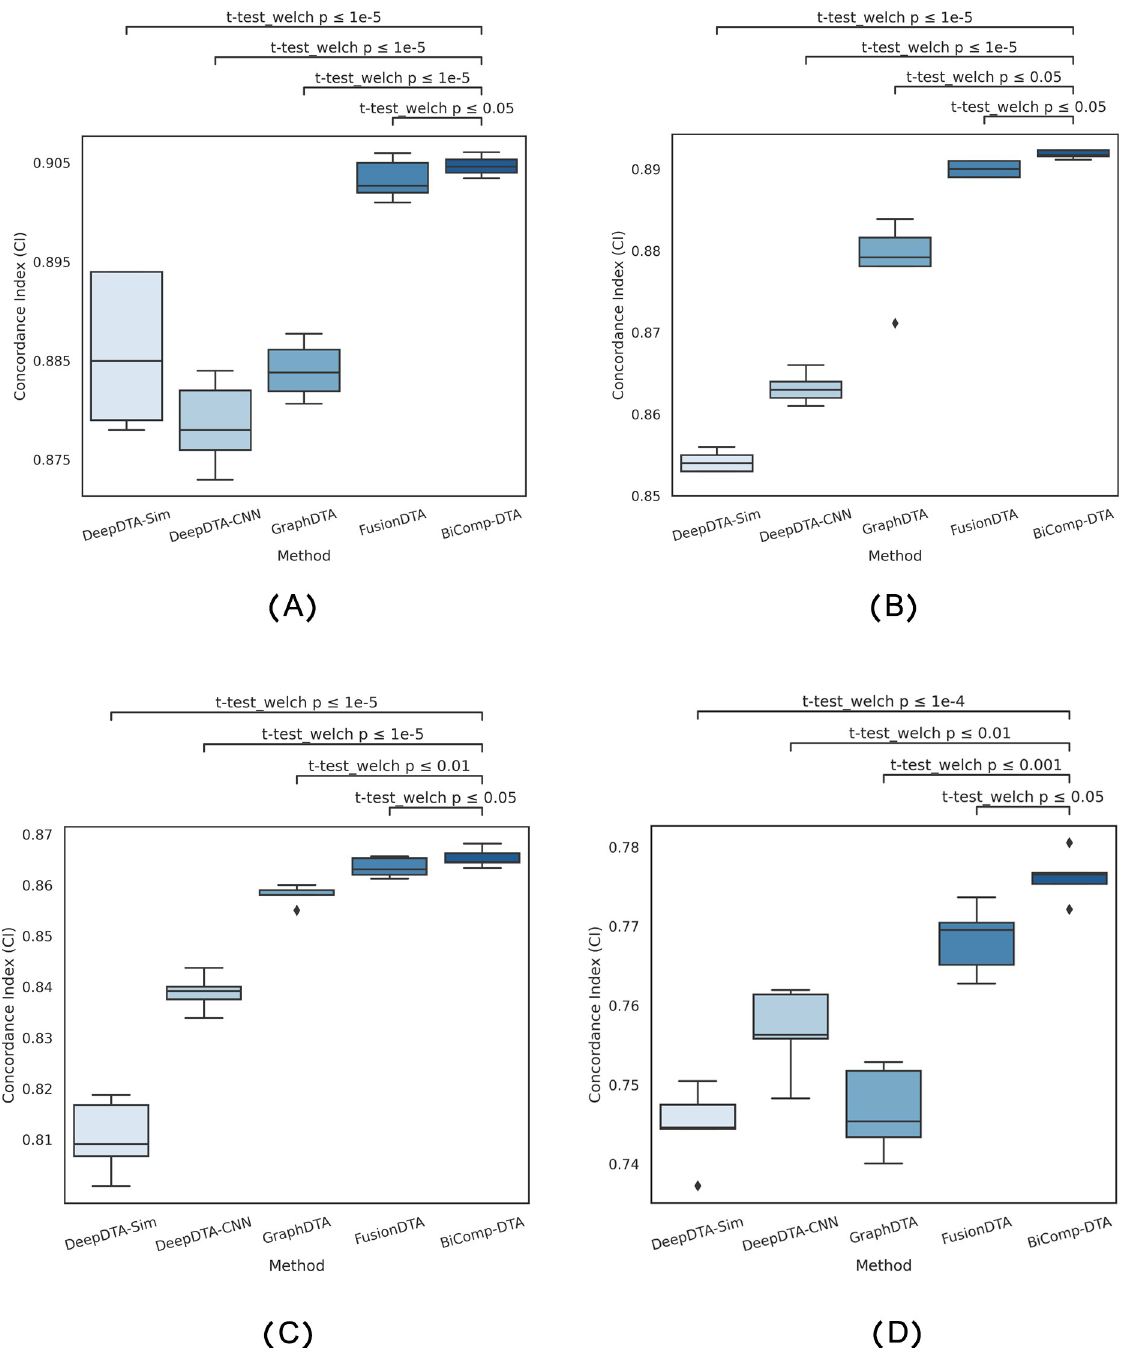
Fig 1. Full distribution of CI values and statistical test results for the BiComp-DTA, compared to the alternative methods for (A) Davis, (B) Kiba, (C) BindingDB, and (D) PDBbind datasets.